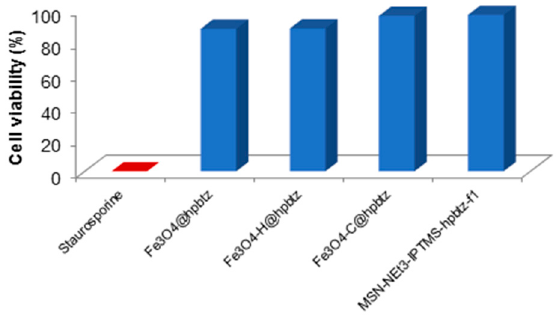
Figure 16. Toxicity of tested nanomaterials on HEK293 cells.